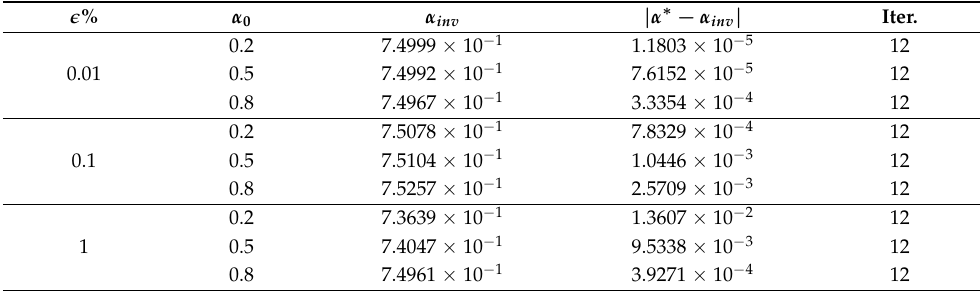
Table 4. Numerical results of different α ∗ = 0.75 with (cid:101) %-degree noise-contaminated data in Test